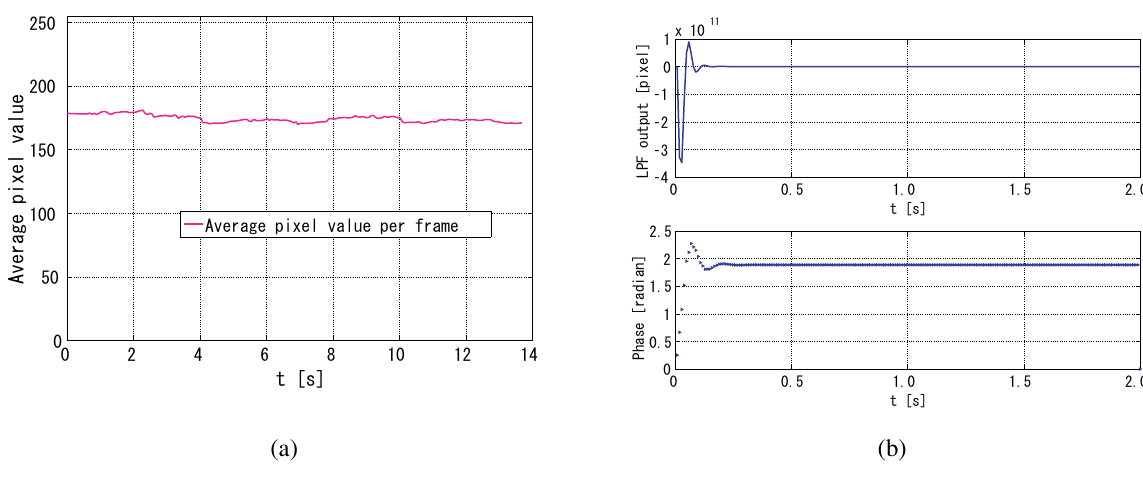
Figure 10. Real-world scene simulation results, (a) average pixel values per frame, (b) output of low pass filter and phase of output